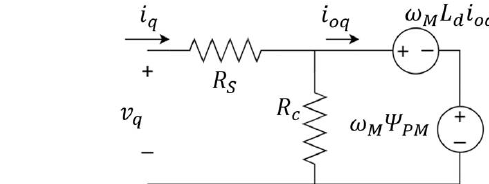
Table 1. Optimization decision variables.